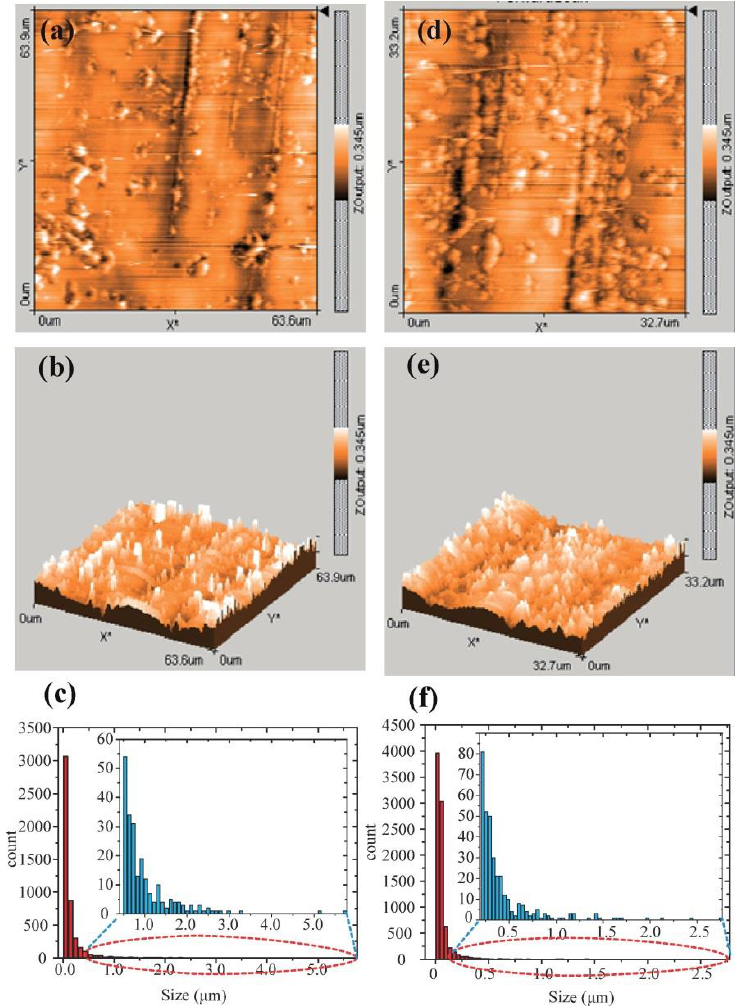
Figure 7. AFM images of the nanocluster deposited at a pressure, voltage, and current of 100 mbar, 0.20 kV, and 240 mA, respectively. ( a ) and ( b ) Two-dimensional and three-dimensional views of the low-resolution AFM scan of 63.6 µm × 63.9 µm. ( c ) Histogram of nanocluster size shown in ( a ) and ( b ). ( d ) and ( e ) Two-dimensional and three-dimensional views of the high-resolution AFM scan of 32.7 µm × 33.2 µm. Histogram of nanocluster of low and high nanoclusters shown in ( c ) and ( f ), respectively.